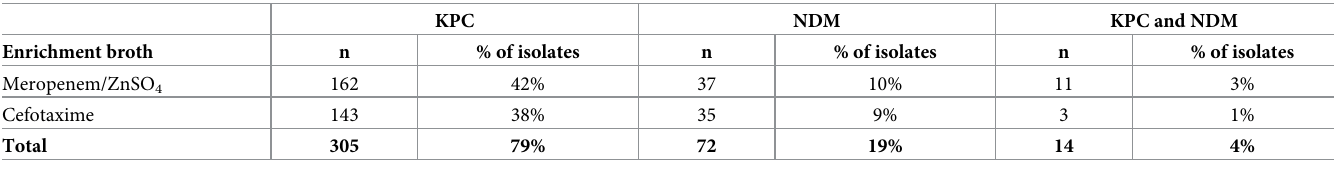
Table 3. Recovery CPE using cefotaxime vs meropenem selective enrichment